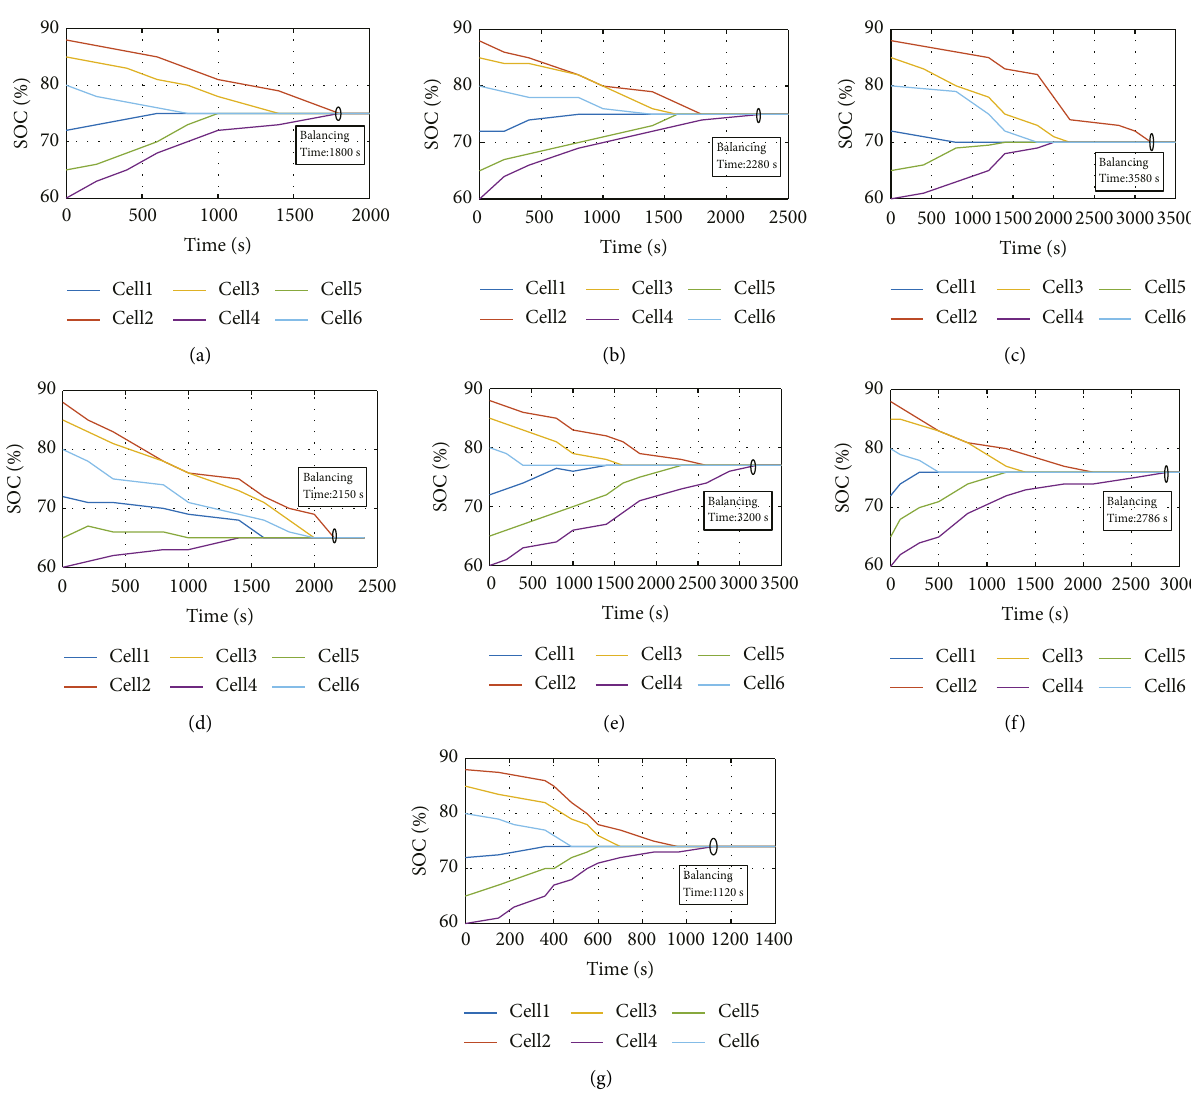
Figure 17: Simulation result for diferent converter topologies for cell balancing with six cells connected in series. (a) Buck-boost converter, (b) Cuk converter, (c) resonant converter, (d) ramp converter, (e) push-pull converter, (f) dual active bridge converter, and (g) fyback